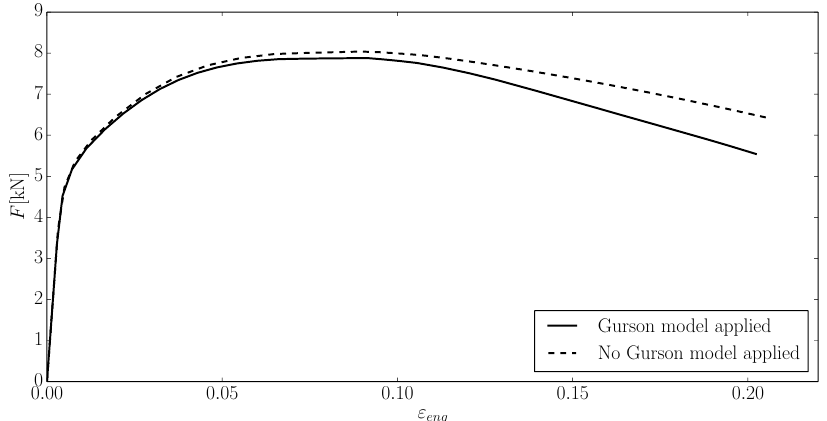
Figure 1. F- ε curves obtained with numerical simulations of the same specimen. One of them using a Gurson model and the other one without